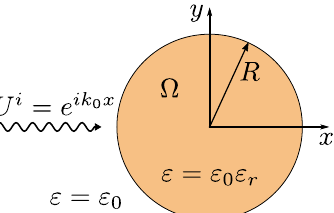
Figure 1: Geometry of the 2D problem of a cylinder. The incident plane wave U i represents E z , as we consider TE polarization.